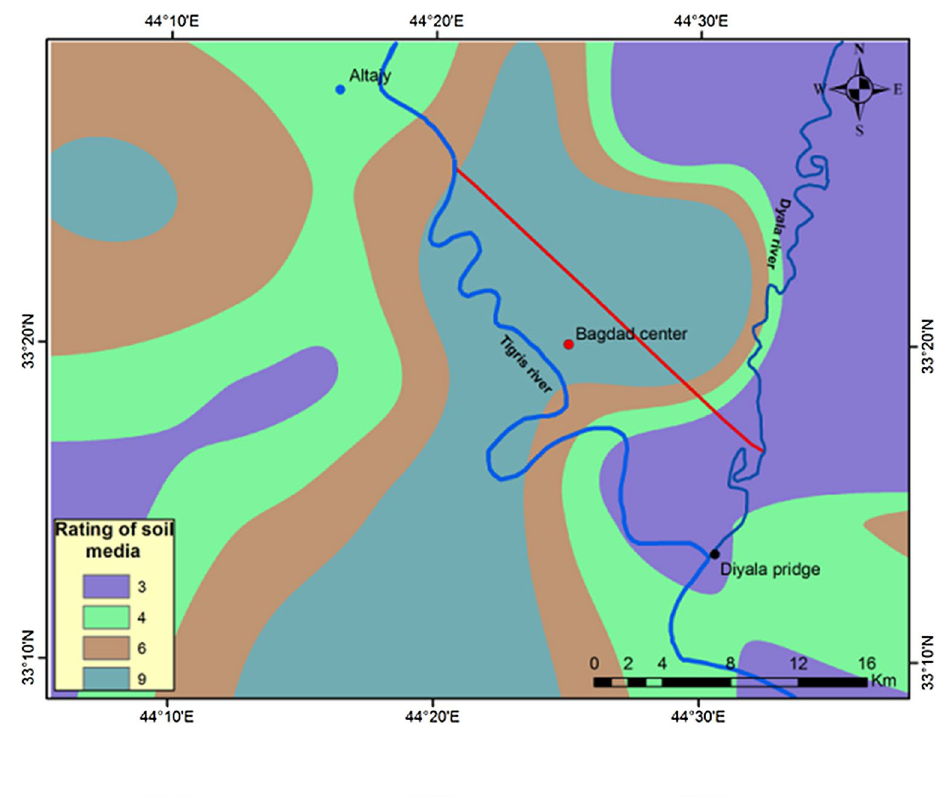
Fig. 10 Rating of topography slope map of the study